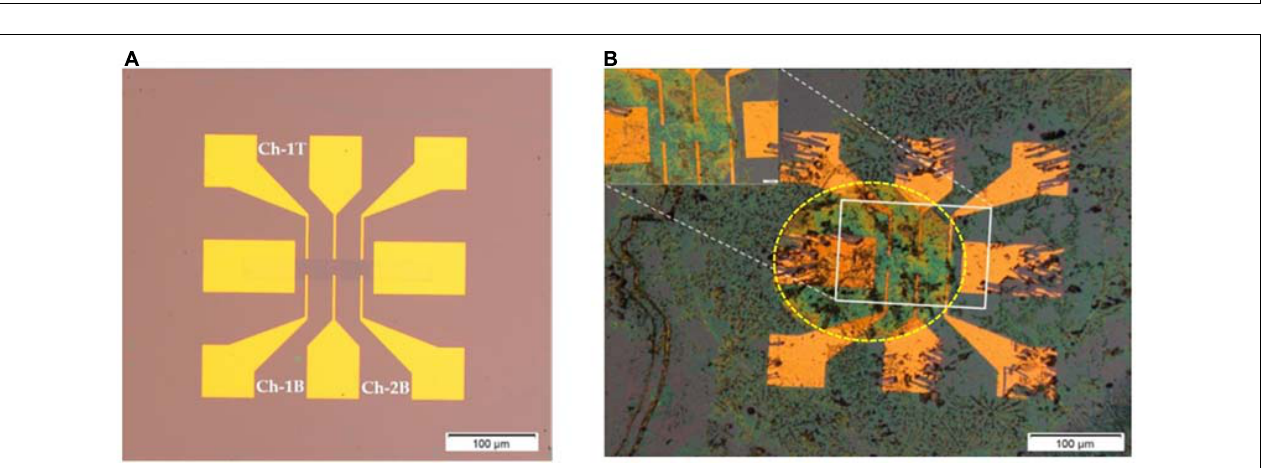
FIGURE 1 | Overview of the processes for GFET fabrication (A) layer of graphene on Si/SiO 2 substrate, (B) LoR deposition, (C) PR deposition, (D) sample below the photolithography mask aligner for UV exposure, (E) etching of graphene channels and chemical developing process, (F) final stage of metallic Cr and Au deposition.